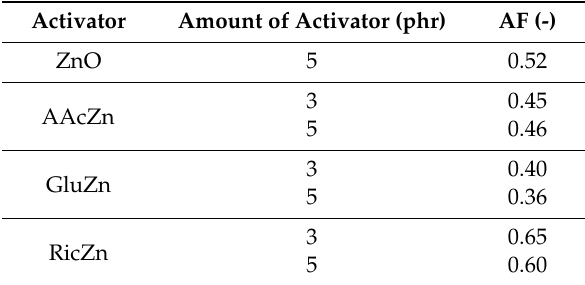
Table 8. Aging factor (AF) of SBR vulcanizates (standard deviation: AF ±